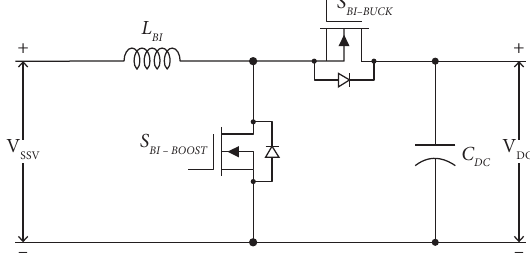
Figure 4: Te bidirectional converter